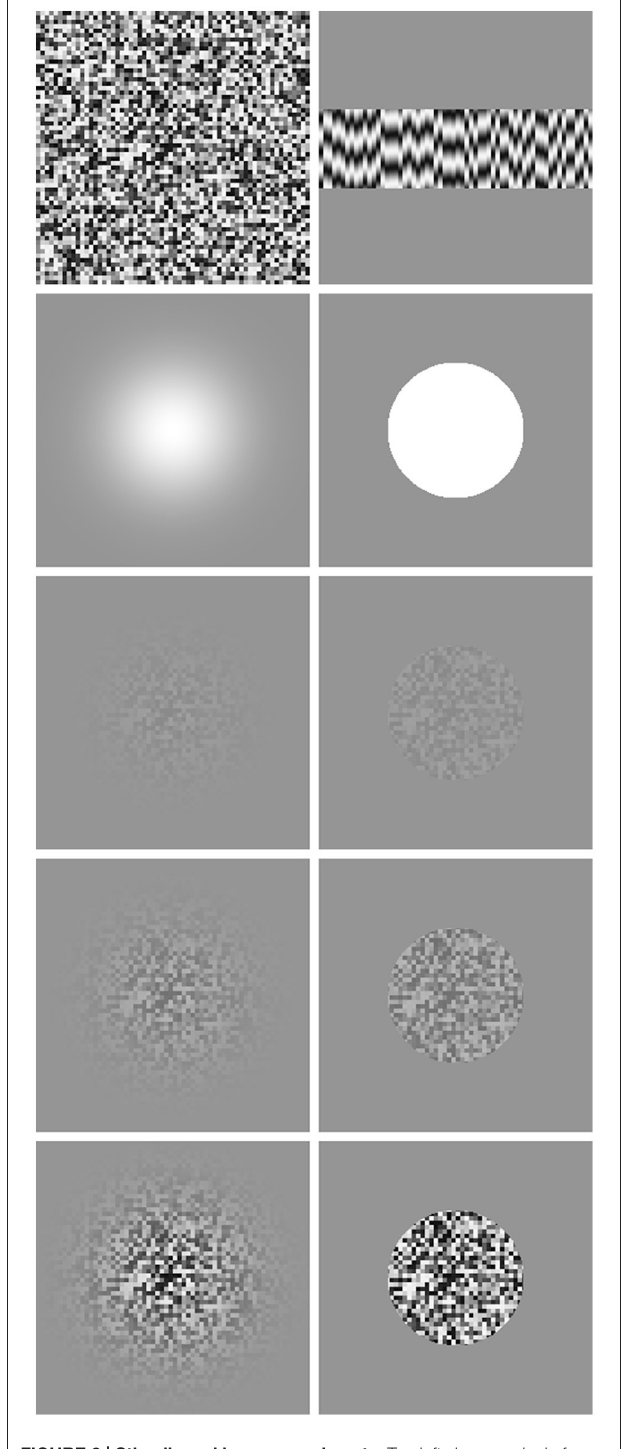
FIGURE 2 | Stimuli used in our experiments. Top left shows a single frame prior to being windowed. Top right shows 72 frame long (600ms) space-time plot, with space along the x-axis and time shown along the y-axis incrementing from top to bottom. Second row shows the masks used to spatially window the stimuli, Gaussian on the left, circular on the right. Remaining images show a single frame at various contrasts (increasing downwards: 0.1, 0.3, and 0.9) for Gaussian windowed stimuli (left) and circular windowed stimuli